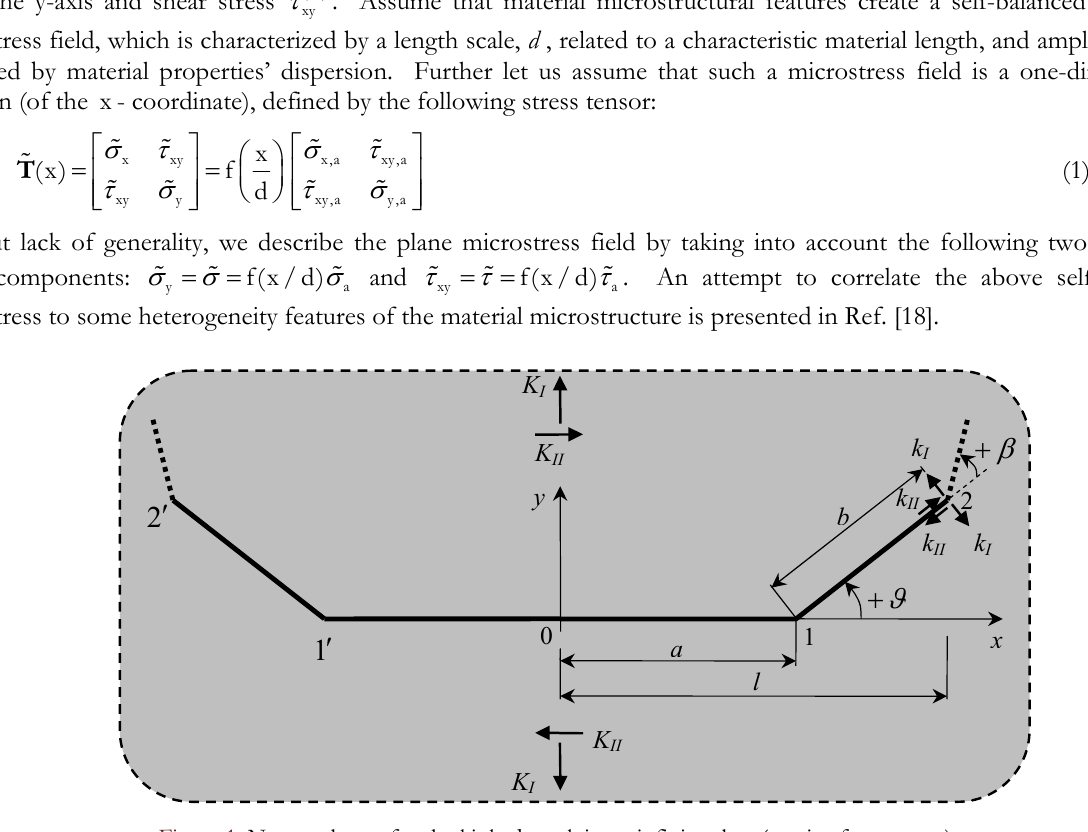
Figure 1: Nomenclature for the kinked crack in an infinite plate (y-axis of